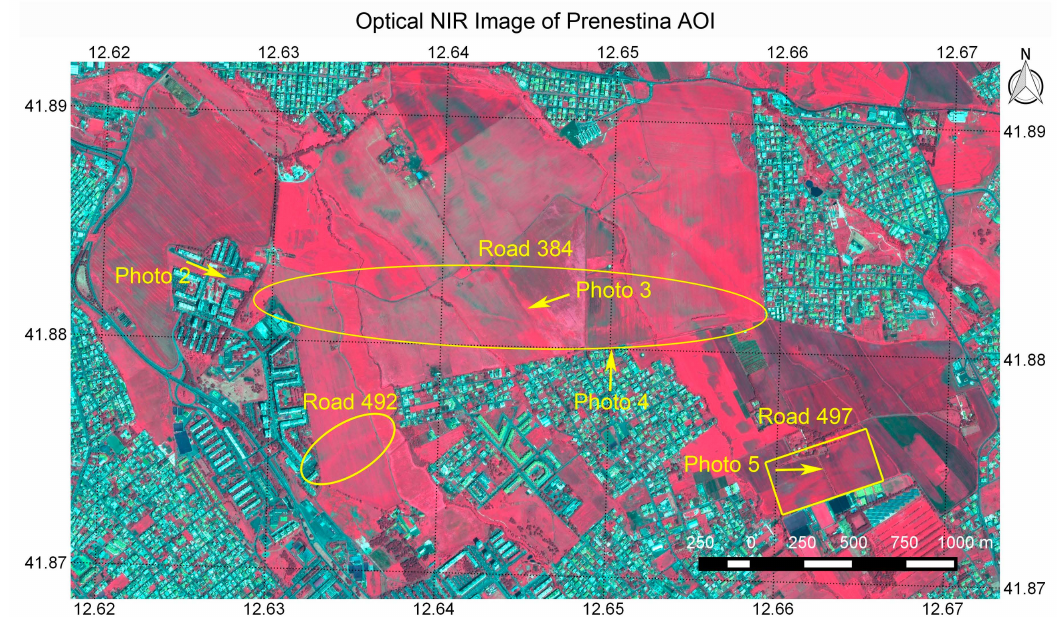
Figure 32. Pleiades image acquired on 20 April 2014 over the Prenestina AOI, pan-sharpened to 0.5 m spatial resolution. NIR, R and G displayed as R, G and B respectively. Pleiades data provided by the European Space